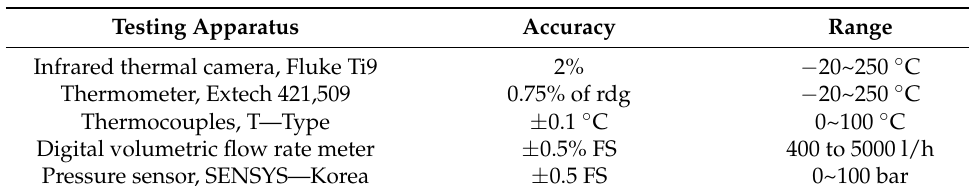
Figure 4. Schematic of the test loop for CO 2 air conditioning system: (a) a CO 2 compressor; (b) a gas cooler; (c) a throttle valve; (d) a microchannel evaporator; (e) an internal heat exchanger; (f) a flow meter; (g) a gas – liquid separator.